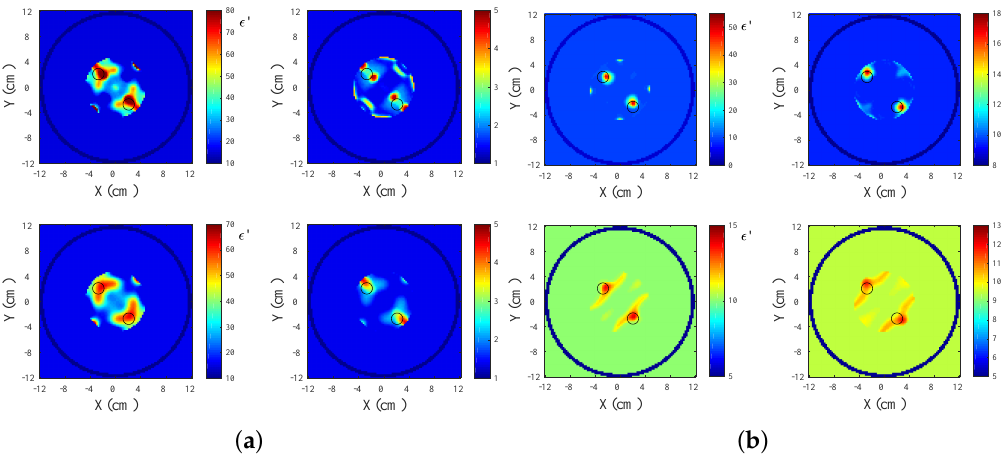
Figure 13. Reconstructed real and imaginary parts of the complex permittivity for the region inside the antenna array of Figure 4 in the presence of two water-filled targets. Data are generated from CST simulations. The top row corresponds to the use of the TwIST solver, and the bottom to the use of the CGLS solver. The figure shows single-frequency reconstructions at ( a ) 1.0 GHz and ( b ) 2.2